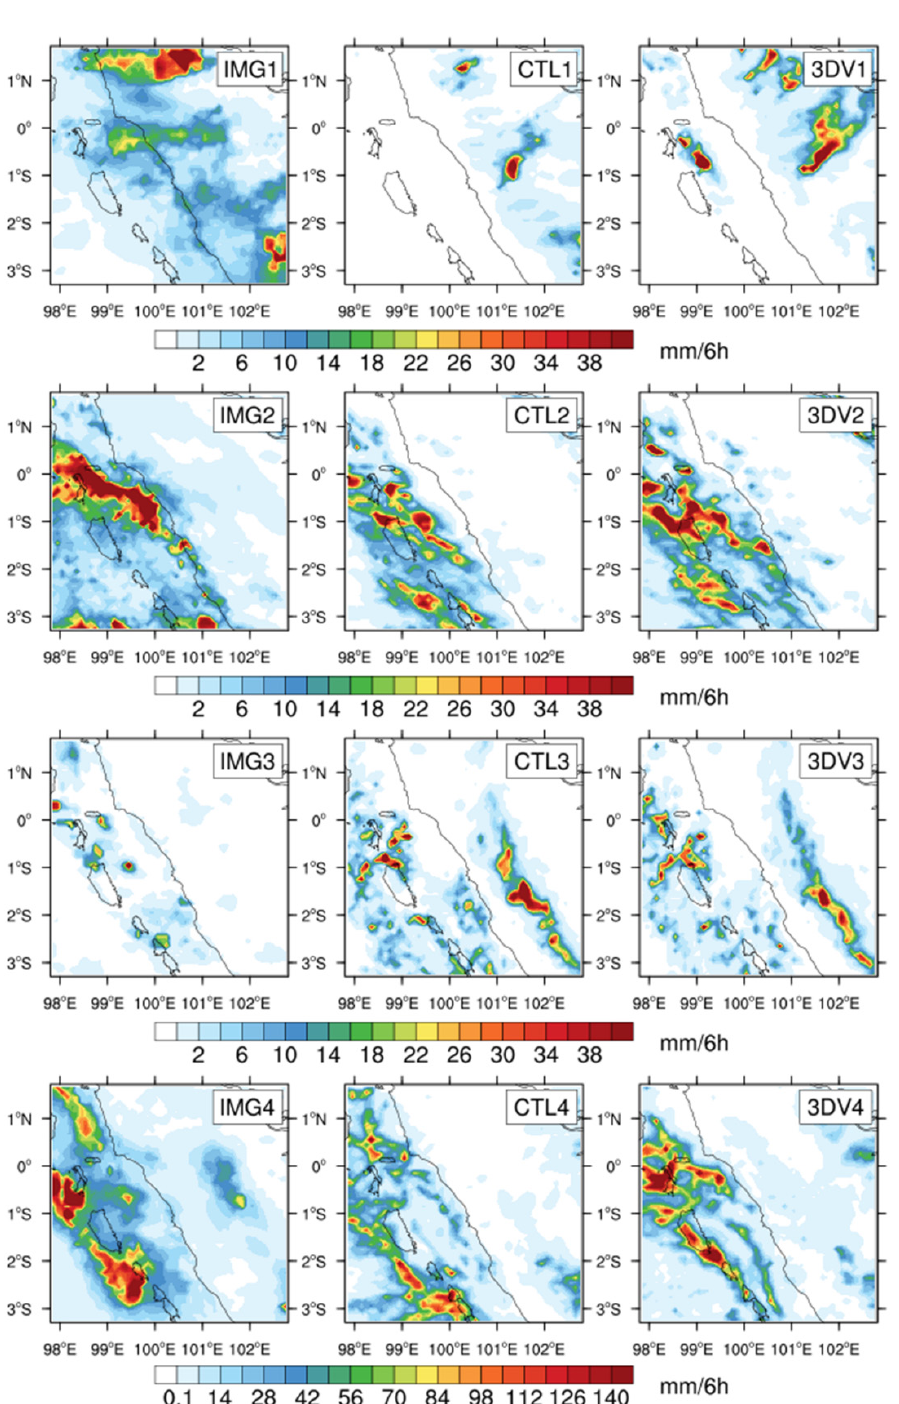
Figure 6. Accumulated precipitation (mm) from IMERG (IMG), CTL simulation, and 3DV simulation during Cases 1–4. The numbers included in the panels indicate the corresponding case number.